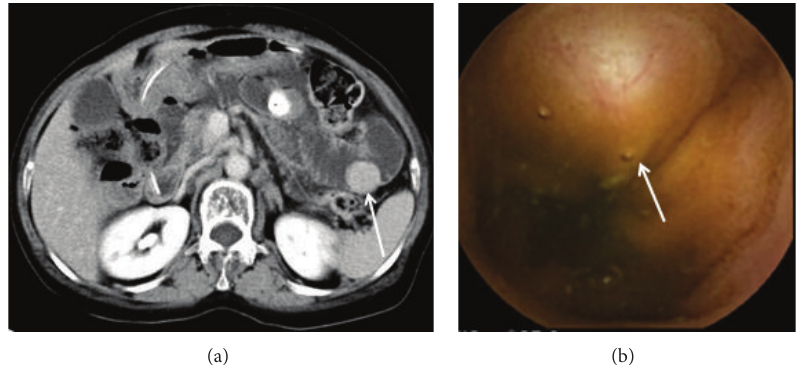
Figure 1: Findings from the computed tomography enteroclysis/enterography (CTE) and capsule endoscopy (CE). (a) Stained tumorous lesions in the small intestine detected by CTE and (b) submucosal tumor lesions confirmed by CE.